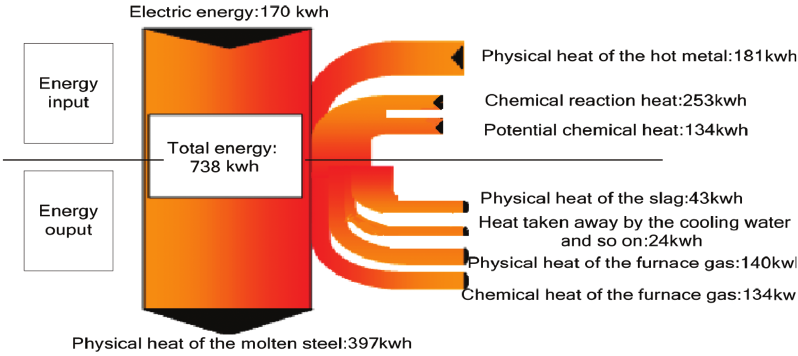
Figure 1: Energy balance during the steelmaking process in the EAF with 50% hot metal